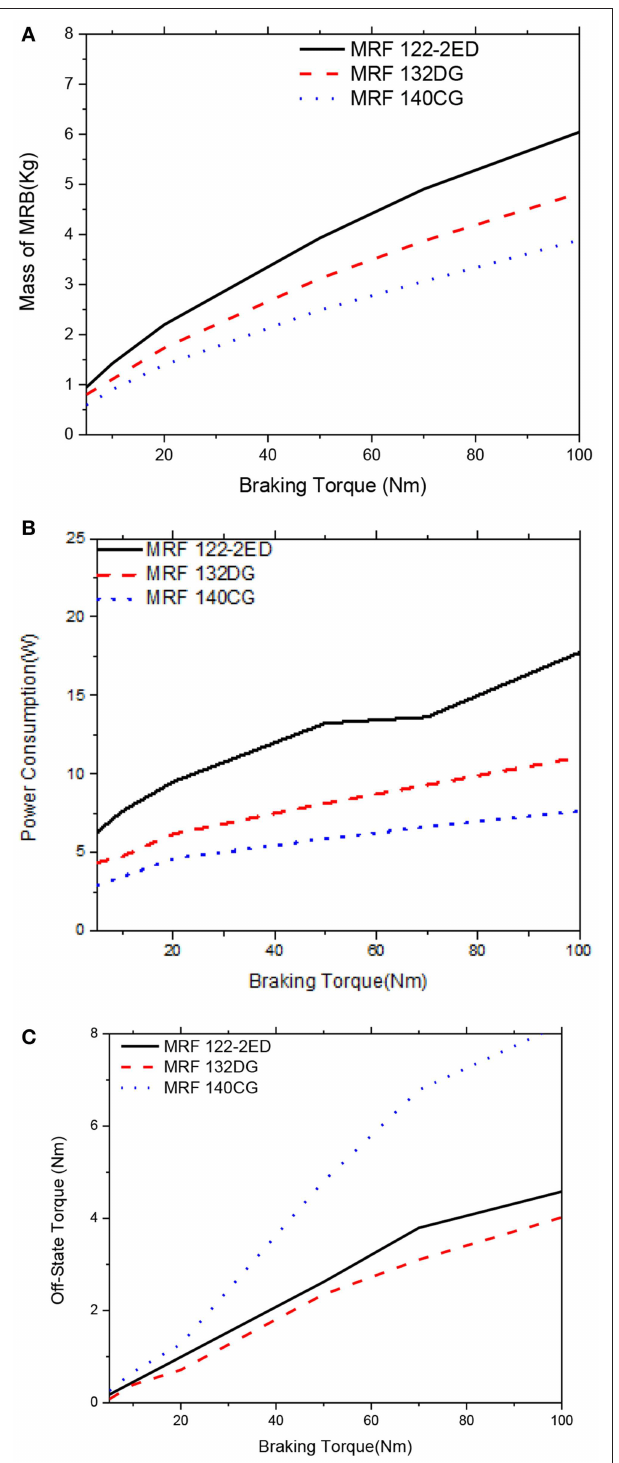
FIGURE 14 | Multi-objective optimization results of the MRBs as a function of braking torque of conventional MRB, α m = α P = 0.5 , α To = 0. (A) Mass as a function of braking torque, (B) Power consumption as a function of braking torque, (C) Off-state torque as a function of braking torque.